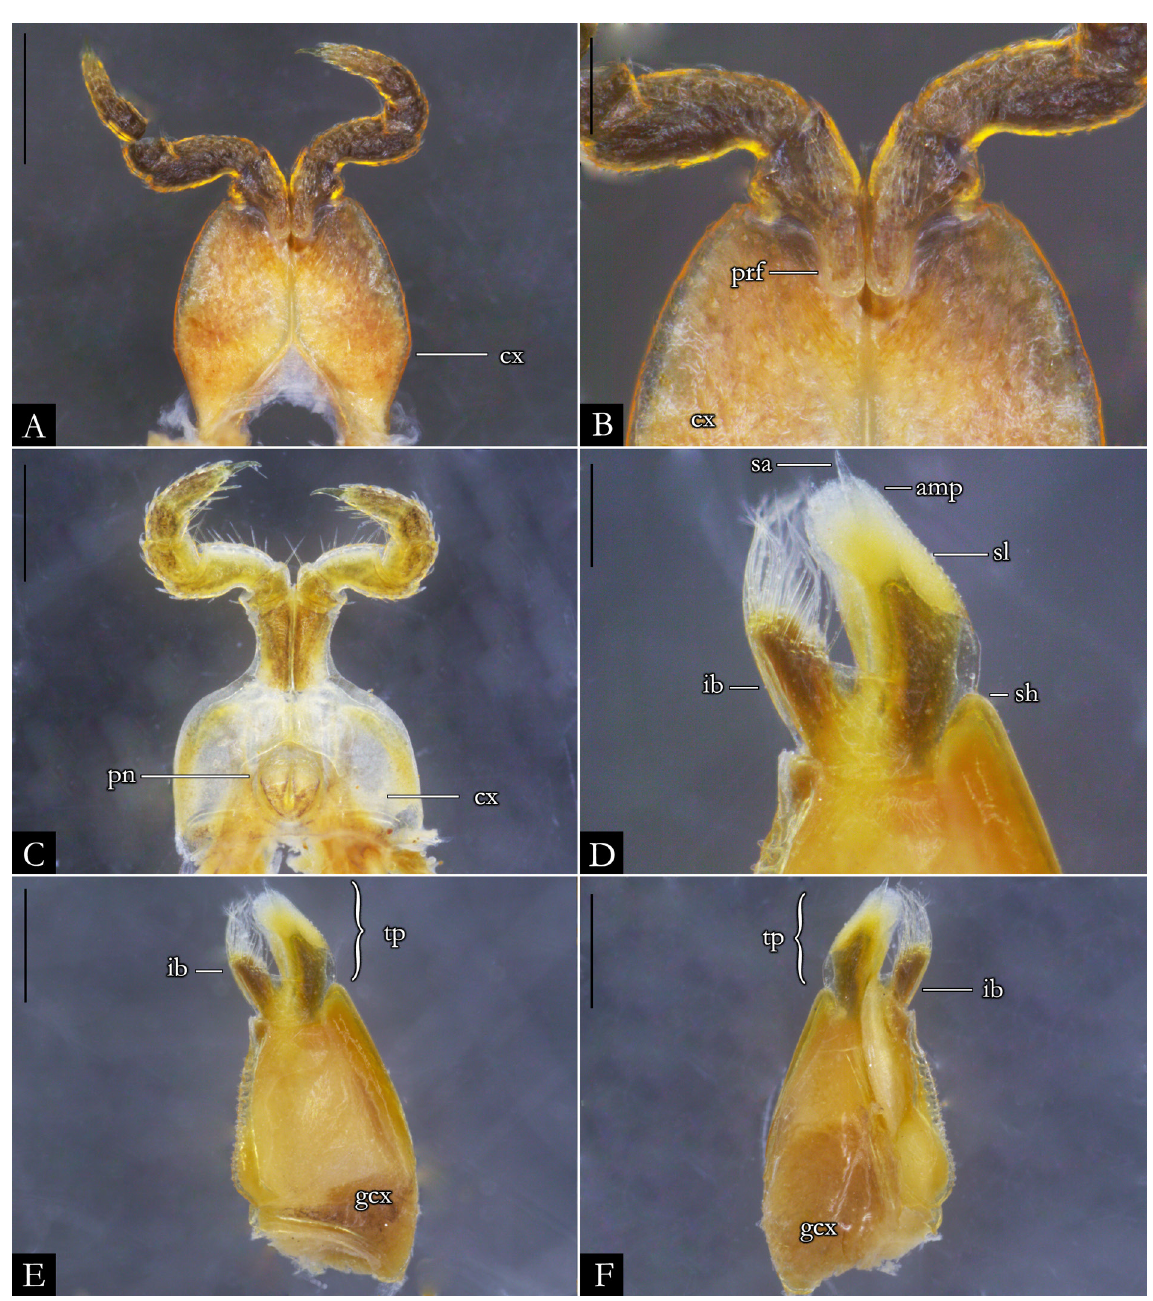
Fig. 152. Pseudonannolene curvata sp. nov., holotype, ♂ (MCN). A . First leg-pair. B . Detail of prefemur. C . Second leg-pair. D . Detail of telopodite, in anal view. E . Left gonopod, in anal view. F . Left gonopod, in oral view. Abbreviations: see Material and methods. Scale bars: A, C, E–F = 0.5 mm; B, D = 0.2